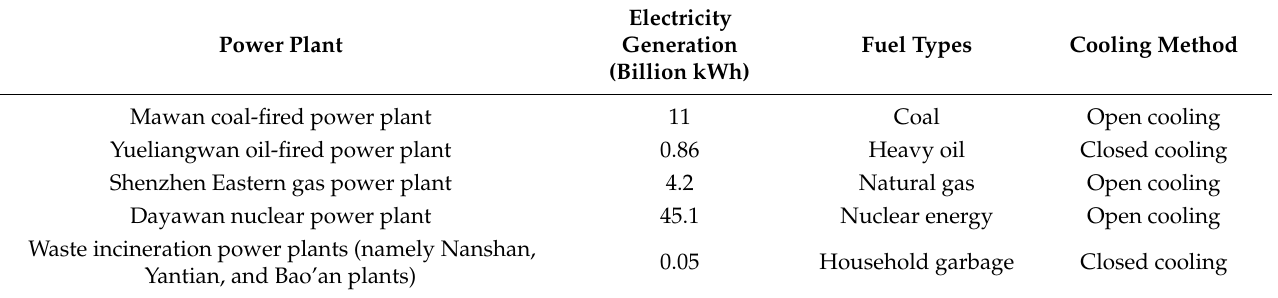
Table 1. Profile of typical electricity generation plants in Shenzhen.